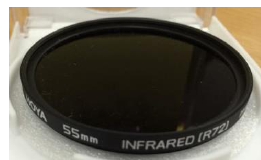
Figure 2. infrared filter 720nm